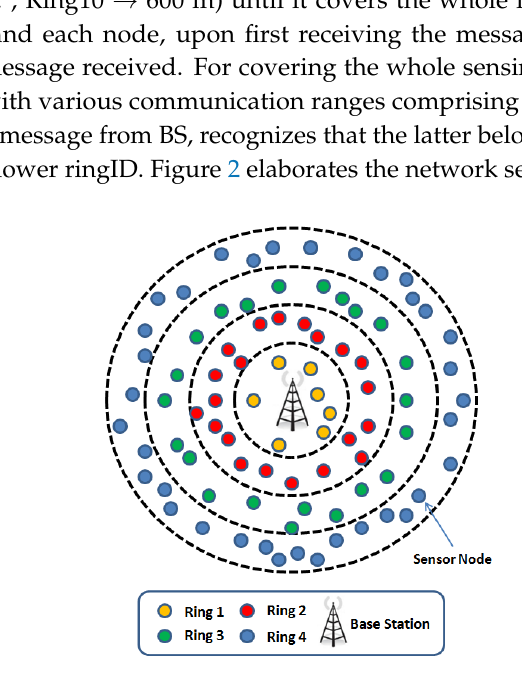
Figure 2. The network configuration phase of RARZ.